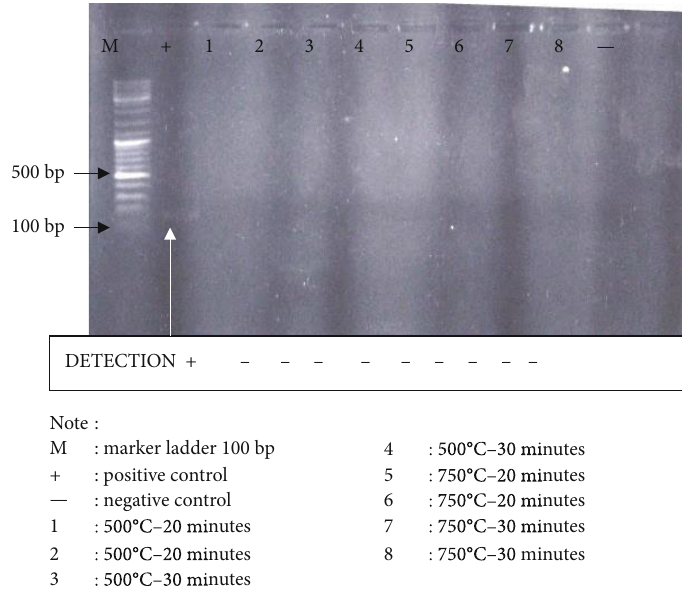
Figure 3: Visualization of D21S11 locus of tooth sample PCR results using a mini primer.